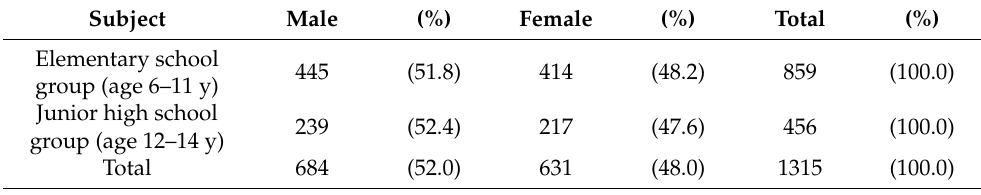
Table 1. Number of participants in each group by